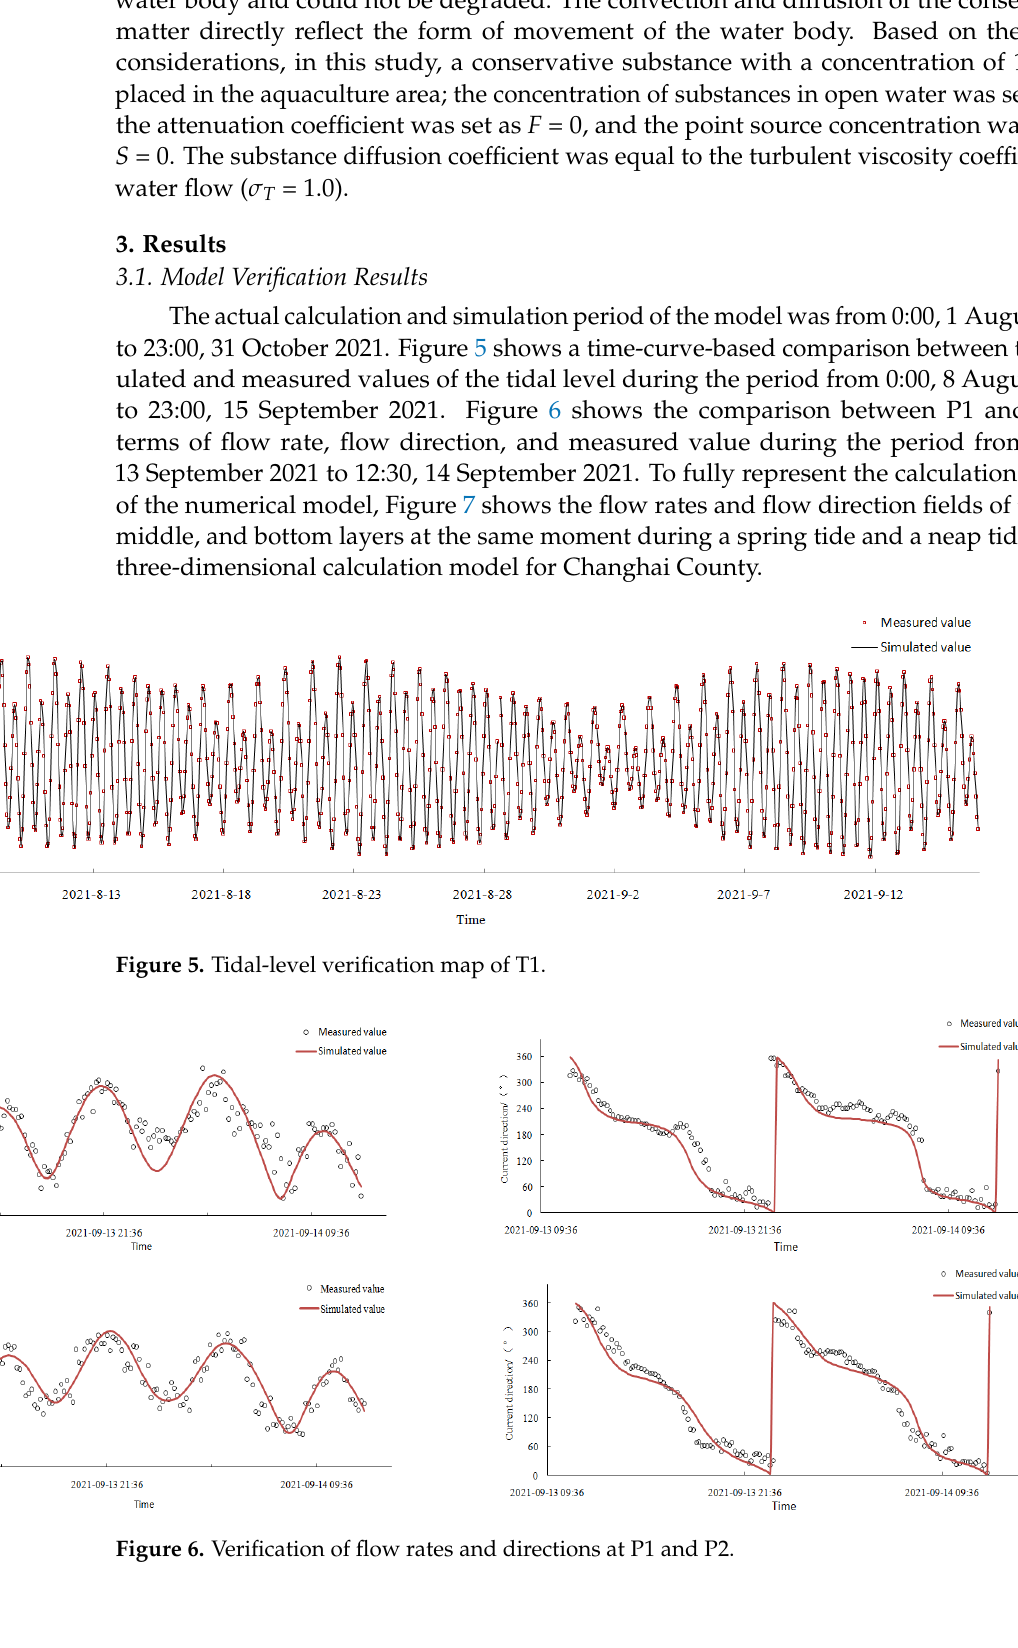
Figure 7. Flow field distribution maps of the top, middle, and bottom layers during a spring tide in the three-dimensional calculation domain of a small area of Changhai County. A comparison between Figure s 5 and6 shows that the results calculated by the model are in good agreement with the measured values, where the error is within an